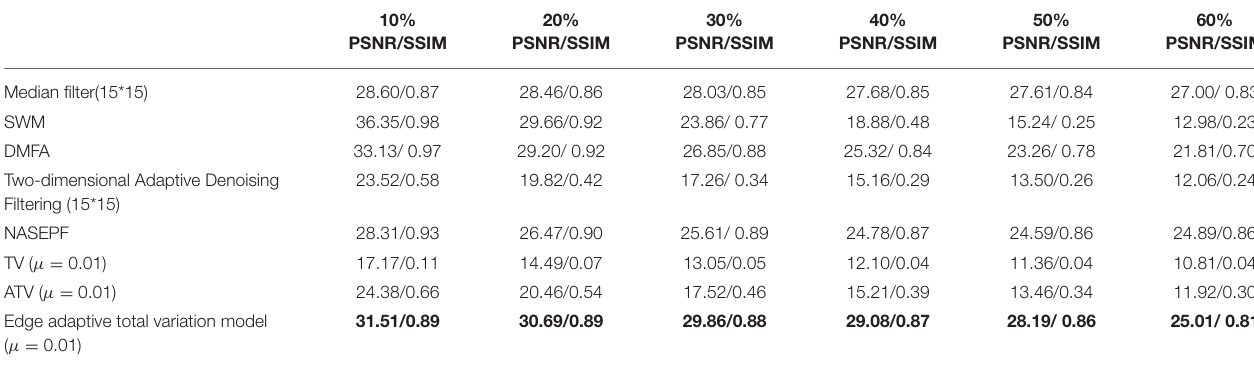
TABLE 1 | PSNR and SSIM scoring results for different salt and pepper noise